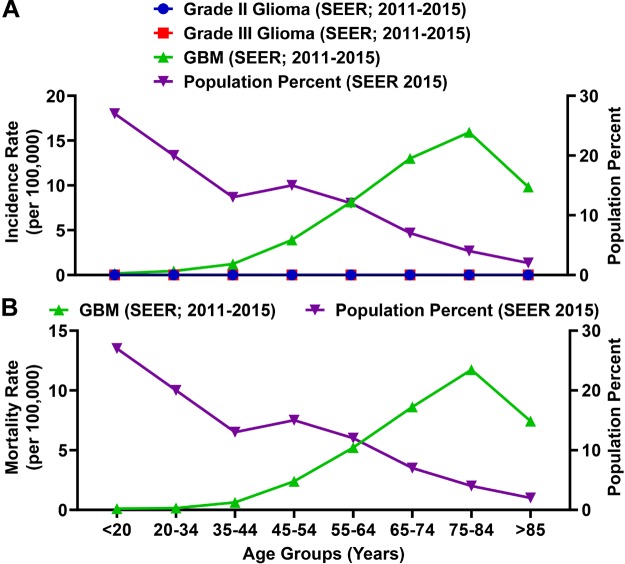
The incidence and mortality rates for glioblastoma (GBM) patients are enriched among the elderly population. (A) SEER incidence rates (per 100,000) for grade II glioma, grade III glioma, and GBM (grade IV glioma; all left axis) compared to the percent of the total population represented for each age group. Grade II and III glioma incidence rates calculated by SEER were >0.015 (per 100,000) for each age category. (B) The SEER mortality rate for GBM as compared to the percent of the total population represented for each age group. Incidence and mortality data is represented as a summation for the years 2011–2015.